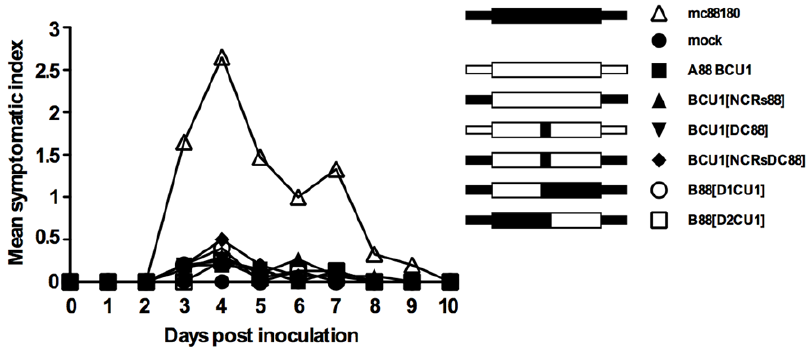
Figure 4. Mean individual symptomatic index between 1 to 10 day post inoculation in chickens inoculated with mosaic recombinant IBDV strains. The symptomatic index was calculated according a scale ranging from 0 to 3 with, with 0 meaning ‘‘lack of signs’’, 1 meaning ‘‘typical IBD signs (ruffled feathers) conspicuous in quiet bird only, the bird stimulated by a sudden change in environment (light, noise, or vicinity of experiment observer) appears normal, motility is not reduced’’; 2 meaning ‘‘typical IBD signs conspicuous even when bird is stimulated, dehydration is apparent, motility may be slightly reduced’’ and 3 standing for ‘‘typical severe IBD signs with prostration or death’’. mc88180 induced significantly more morbidity than all other viruses from 3 to 9 DPI (p # 0.0001 to p # 0.003), whereas no significant difference in the severity of clinical signs was observed between the groups receiving the other viruses or mock-inoculated., A simplified representation of the chimeric segments B (based on the ones described in Figure 1) used in association with the segment A of 88180 to generate the indicated mosaic recombinant viruses is shown.